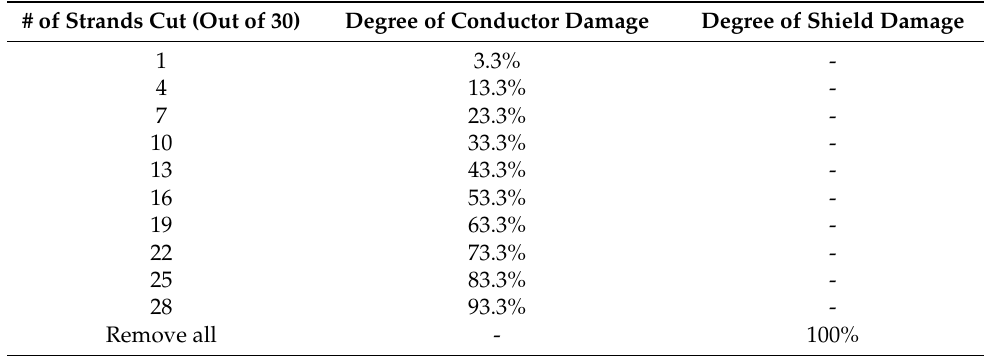
Figure 14. Three scenarios of simulated conditions. Table 1. Degrees of damage severity.